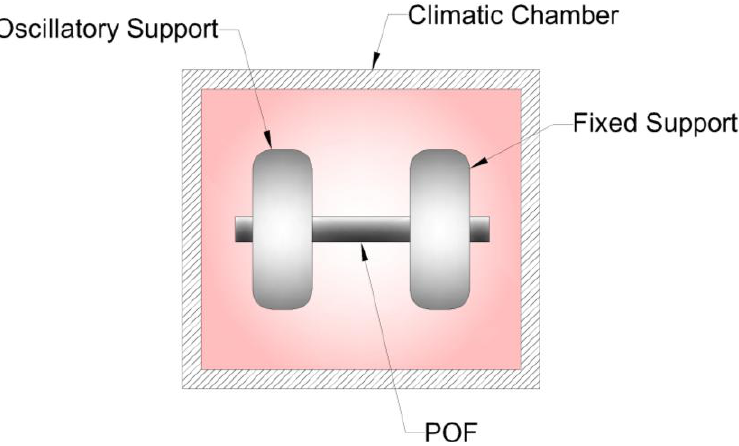
Figure 1. Dynamic mechanical analyzer employed on the polymer optical fiber (POF) characterization.